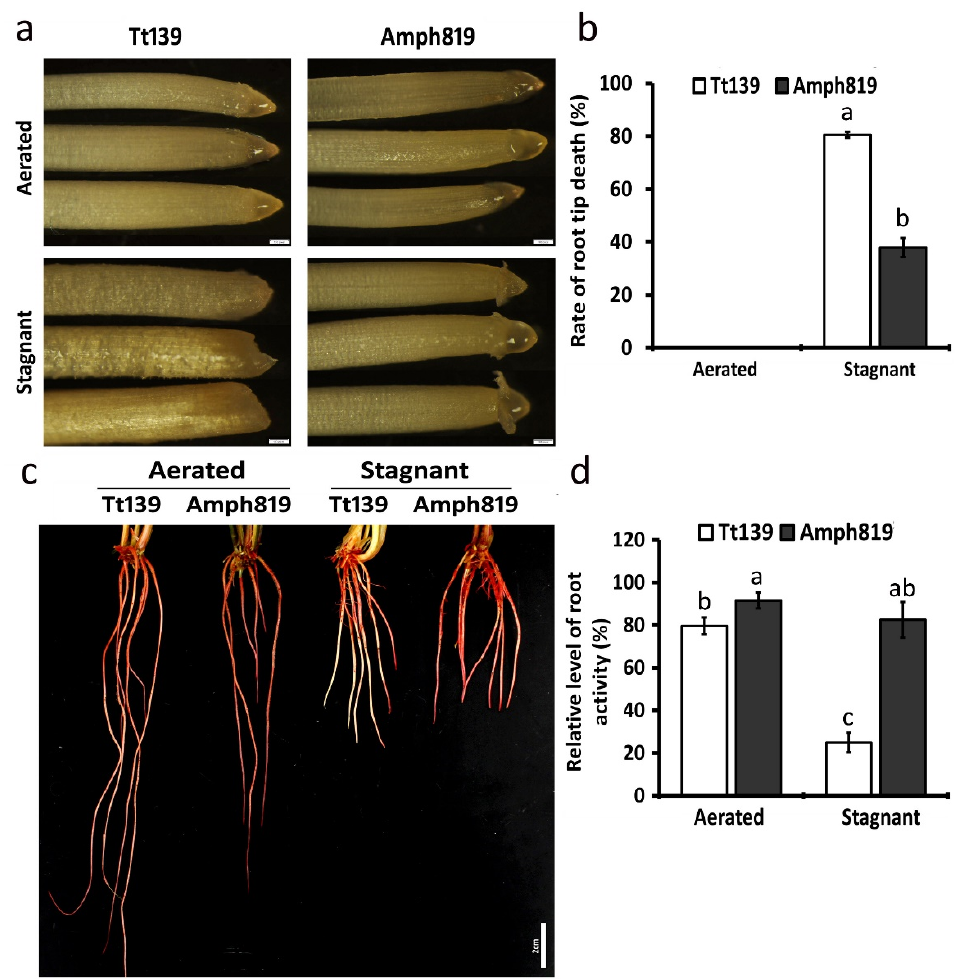
Figure 7. Effect of hypoxic stress on root activity. ( a ) Phenotypes of Tt139 and Amph819 root tips under aerated and stagnant conditions for 3 weeks. Scale bars = 200 μ m. ( b ) Rate of root tip death. ( c ) TTC staining of secondary roots grown in aerated and stagnant conditions. The red color indicates the TTC is reduced by dehydrogenases in living cells. Scale bar = 2 cm. ( d ) Relative Level of root activity. These data are based on the ratio of root staining length (red color)/root length by TTC staining. Values are means ± SE ( n = 12) from 3 plants in each treatment. Letters indicate significant differences between means, determined using Duncan’s multiple range test (5% α ).